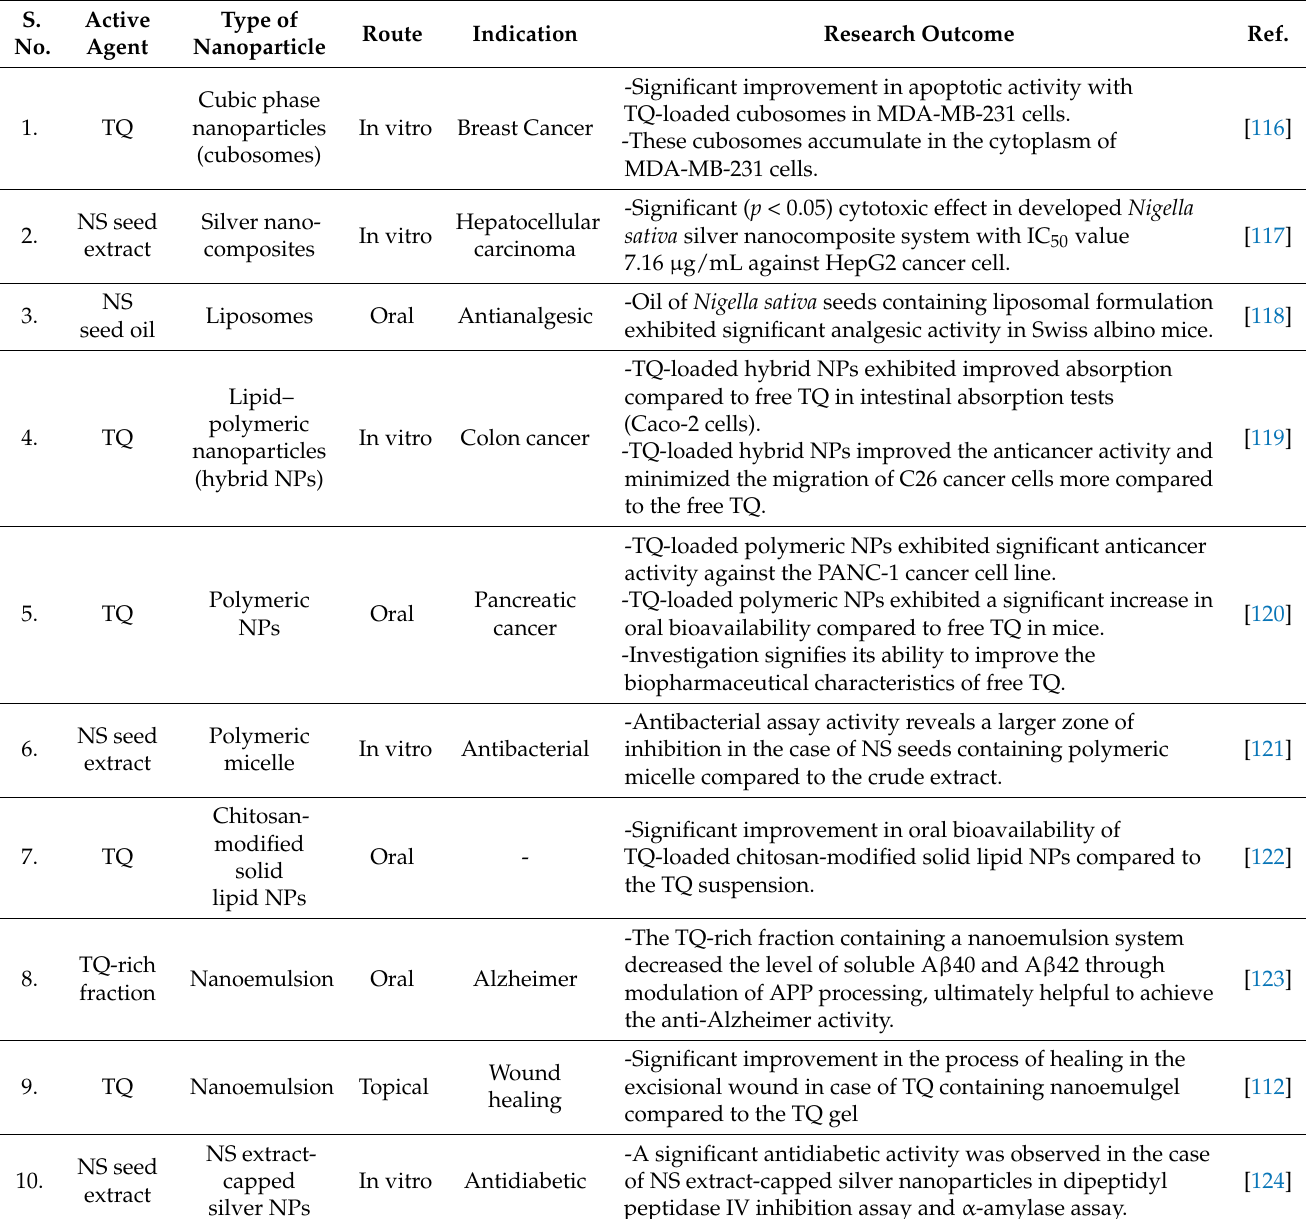
Table 2. Nanotechnology-mediated drug delivery approach utilized to improve the therapeutic efficacy of Nigella sativa and its active constituent (TQ) in different disease